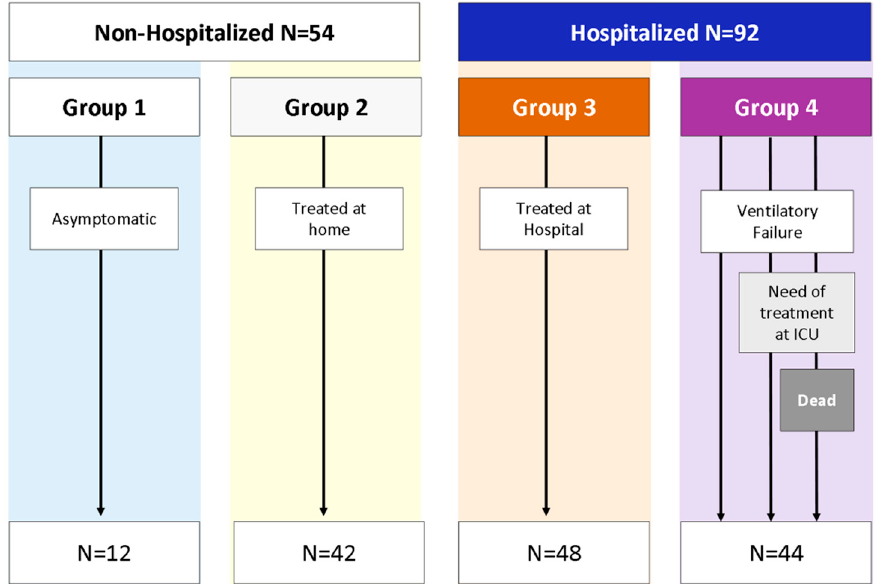
Figure 1. Classification of patients according to the most critical event during the evolution of the disease. (Group 1) Non-Hospitalized patients who did not develop symptoms. (Group 2) Non-Hospitalized patients who developed mild symptoms. (Group 3) Hospitalized patients with mild to moderate symptoms. (Group 4) Hospitalized patients with ARDS.